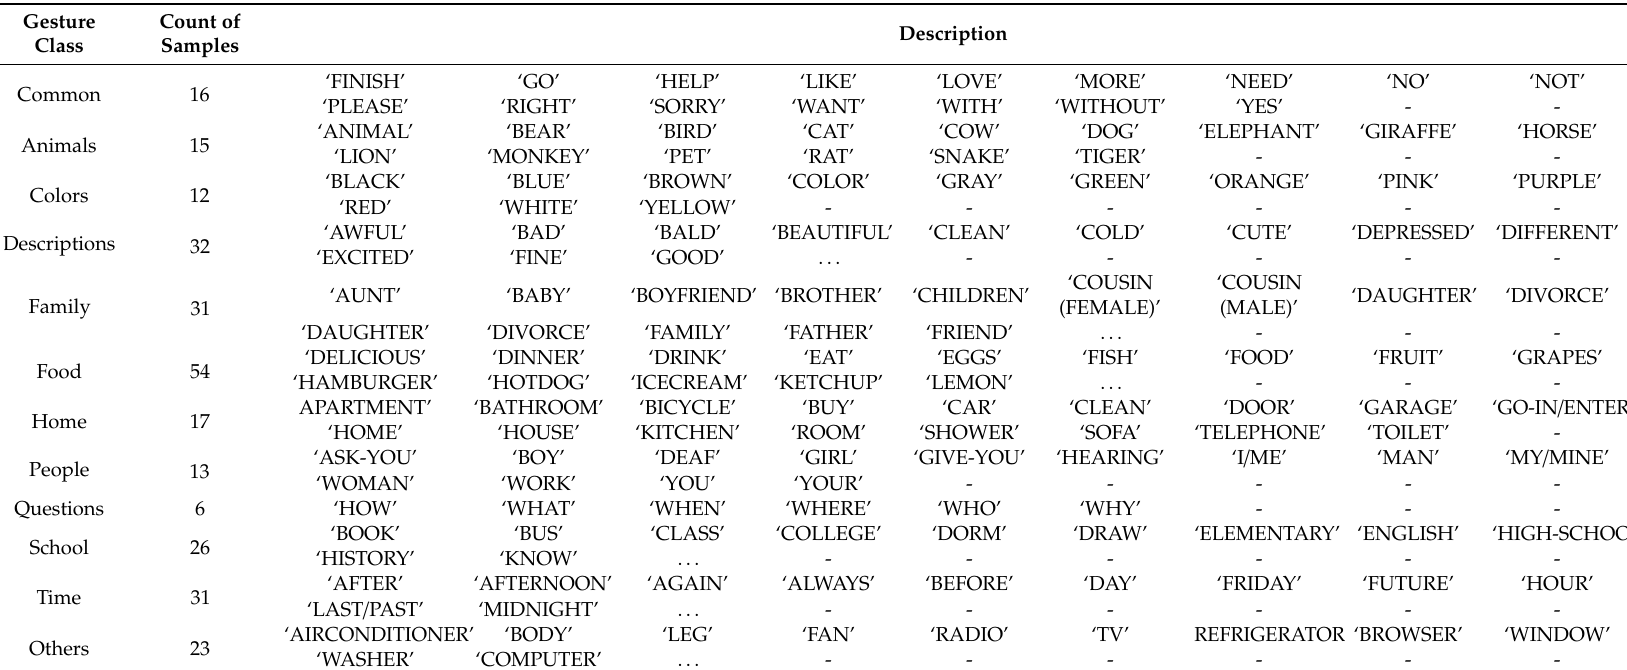
Table 1. Gesture class representation—part of the complete dataset